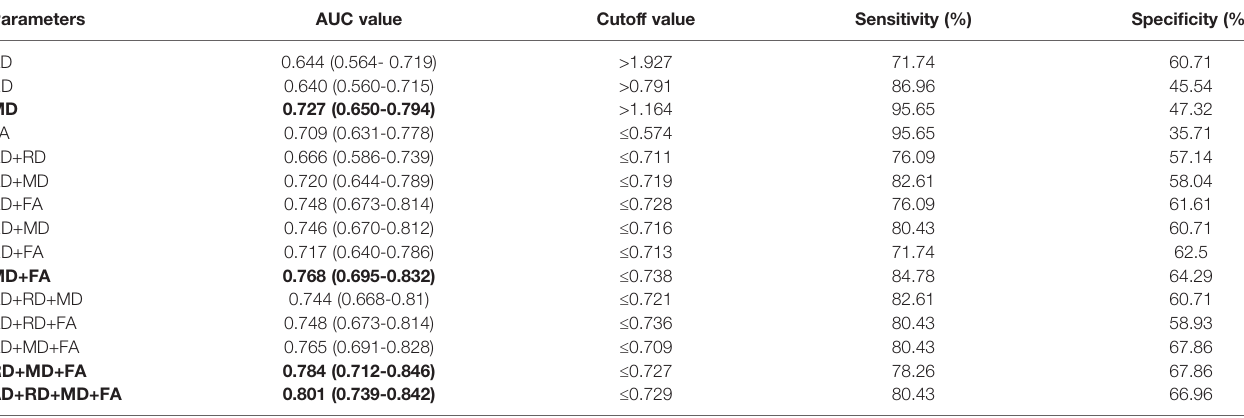
TABLE 3 | The receiver operating characteristics (ROC) analysis of single or combined DTI parameters of the optic nerve to differentiate patients with and without dysthyroid optic neuropathy (DON). Parameters